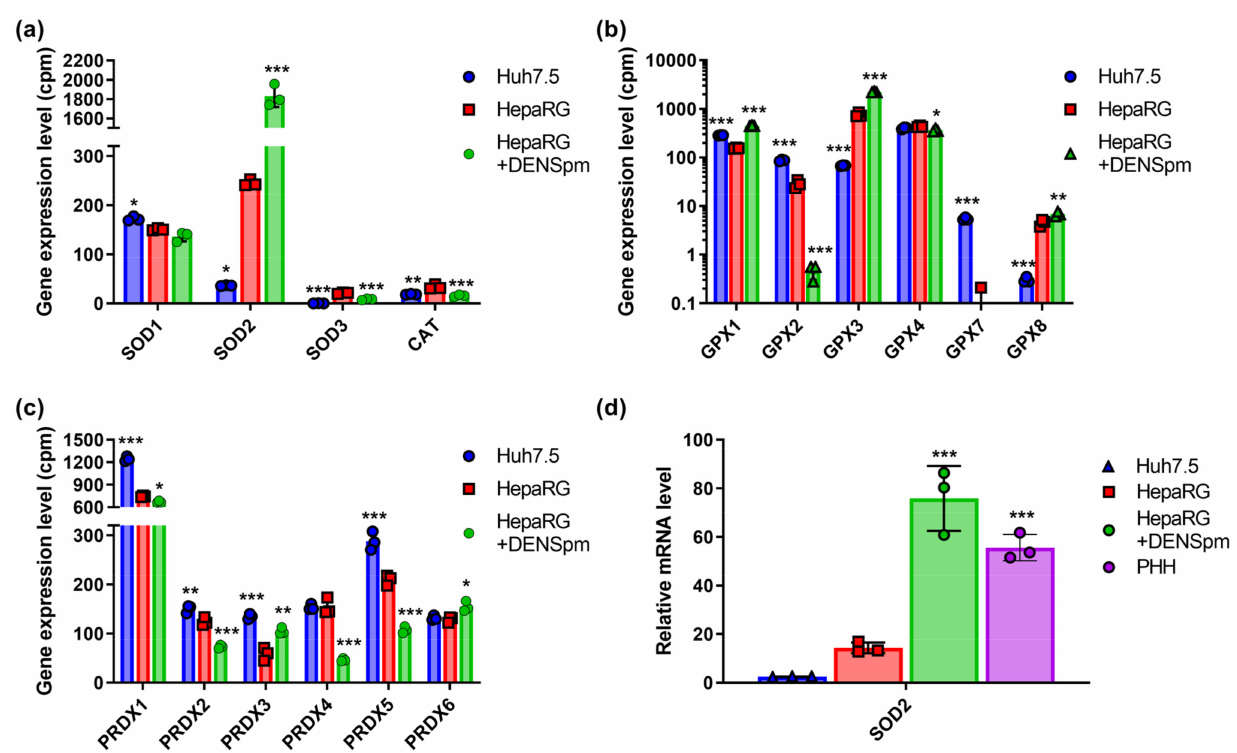
Figure 2. Relative mRNA levels of ROS-scavenging enzymes in hepatoma Huh7.5 cells, hepatocyte- like HepaRG cells, and in HepaRG cells treated with DENSpm, assessed by RNAseq analysis. ( a ) Levels of superoxide dismutases (SOD) and catalase (CAT) mRNA, ( b ) levels of glutathione peroxidases (GPx) mRNA, and ( c ) levels of peroxiredoxins mRNA. ( d ) Relative levels of superoxide dismutase 2 (SOD2) mRNA in these cells and PHH assessed by RT-qPCR and normalized to the levels of GUS mRNA. Bars are means ± S.D. Statistical significance was analyzed by ANOVA with Tukey’s post hoc test. Statistical significance is presented for the comparison of cells with the differentiated HepaRG cells. * p < 0.05, ** p < 0.01, and *** p <